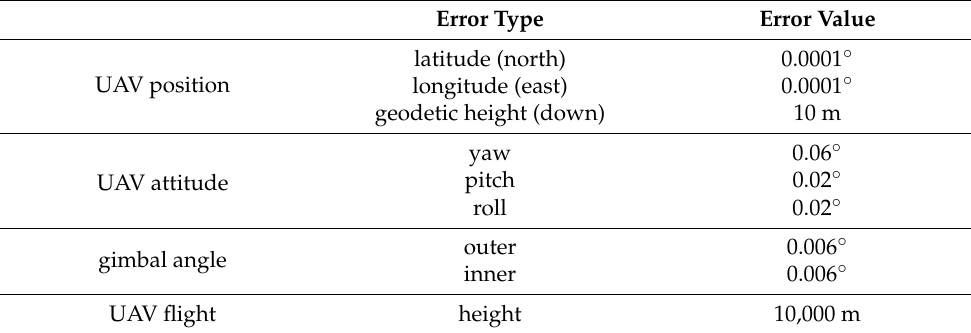
Table 4. Simulation experiment parameters in [22].